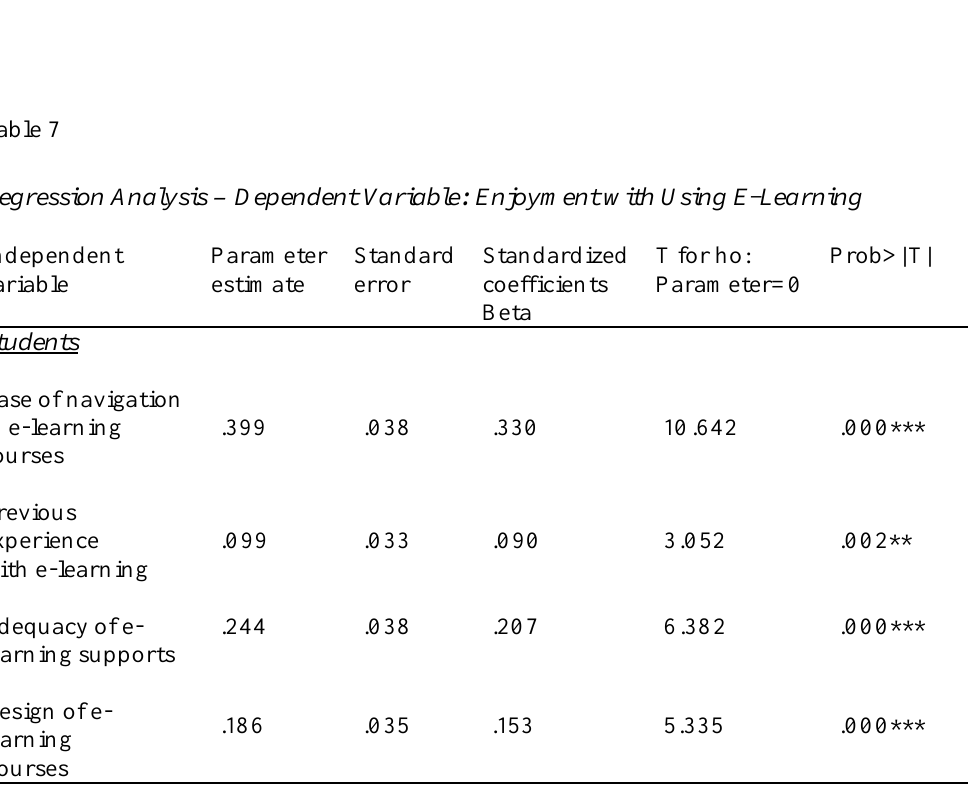
Regression Analysis – Dependent Variable: Enjoyment with Using E-Learning Independent variable